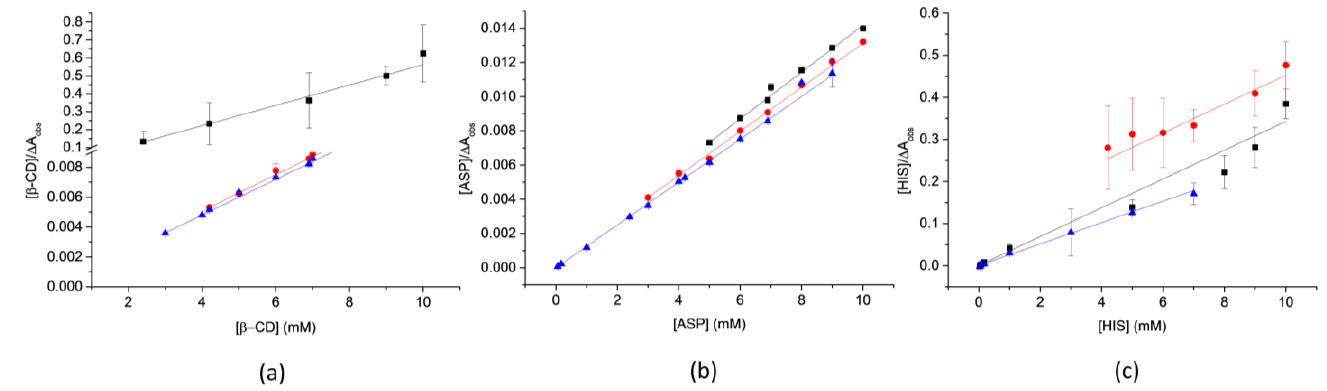
Figure 2. Scott plot of systems containing: ( a ) β -CD; ( b ) ASP; ( c ) HIS; ( ) OxyCl-I, ( ) OxyCl-II, and ( ) OxyCl-III.